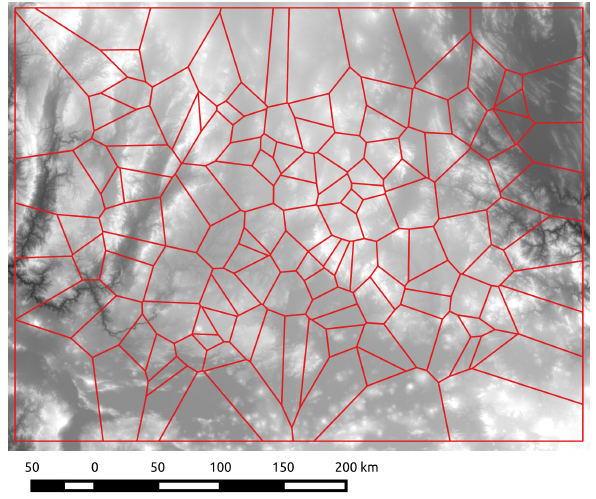
Figure 1: Limits (red) of the 140 random spatial units (”pseudo municipalities”) above the digital elevation model (grey scale)